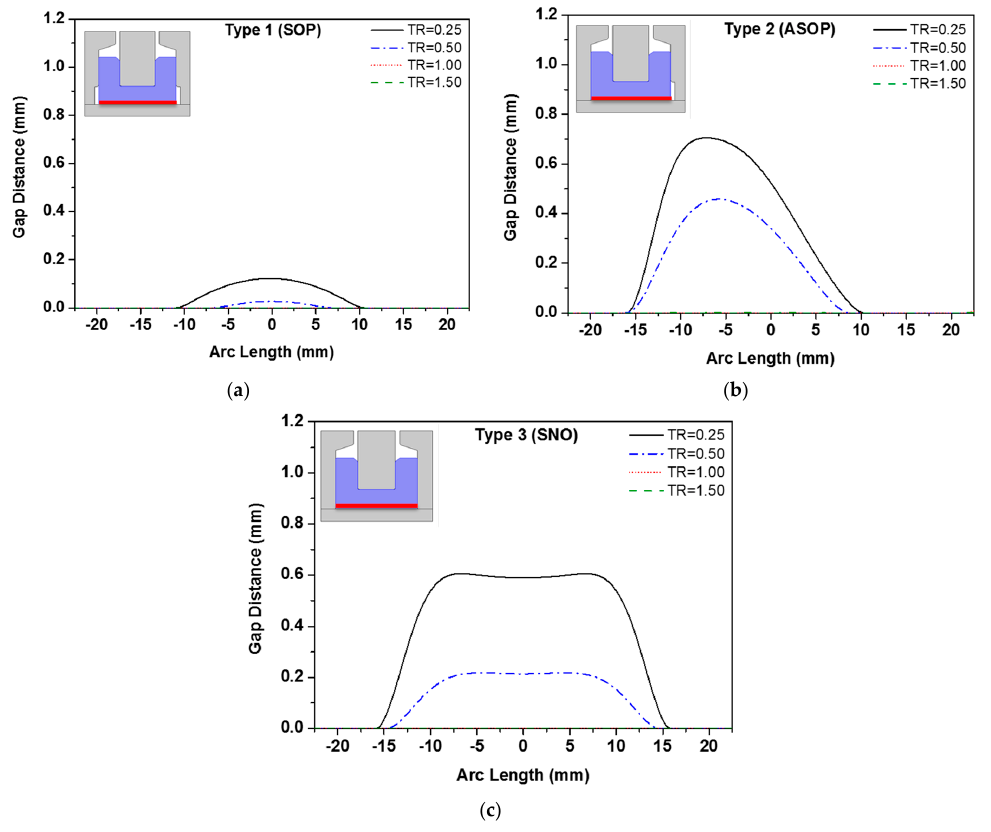
Figure 6. Gap-distance profile along the interface between the outer area of the UMS and the surrounding retainer at 40% of axial compression during assembly: ( a ) type 1, ( b ) type 2, and ( c ) type 3. SOP: symmetric open groove; ASOP: asymmetric open groove; SNO: symmetric no groove.